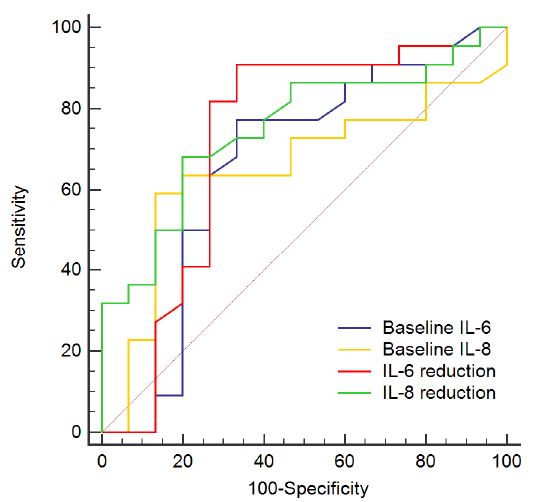
Figure 2. ROC curve of baseline IL-6 values, baseline IL-8 values, IL-6 reduction from T0 to T1 and IL-8 reduction from T0 to T1 for the identification of patients with UC that achieved a clinical response to therapy at T2.